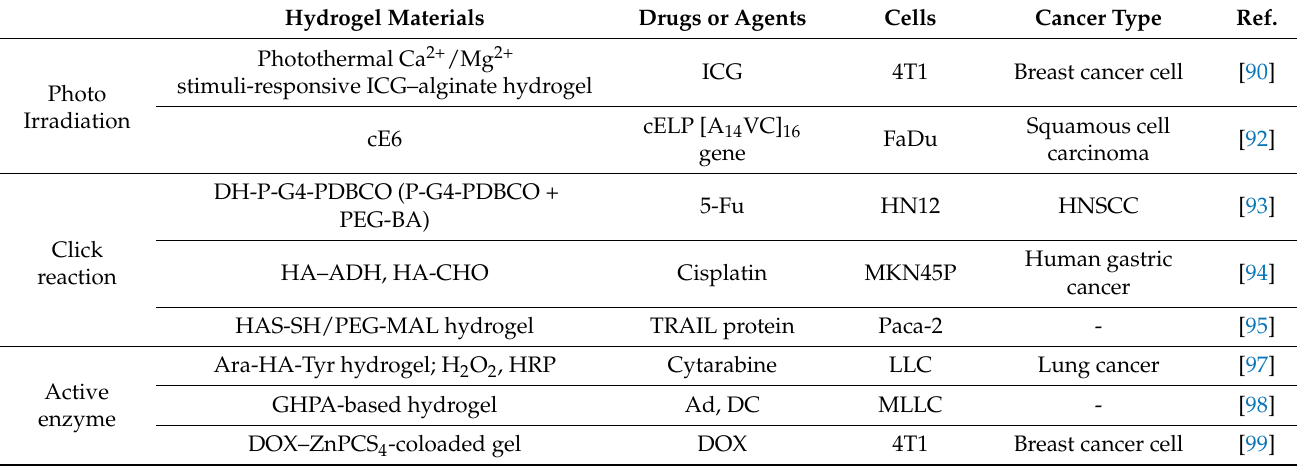
Table 2. Intratumoral injection using an injectable hydrogel through covalent bonding with anticancer